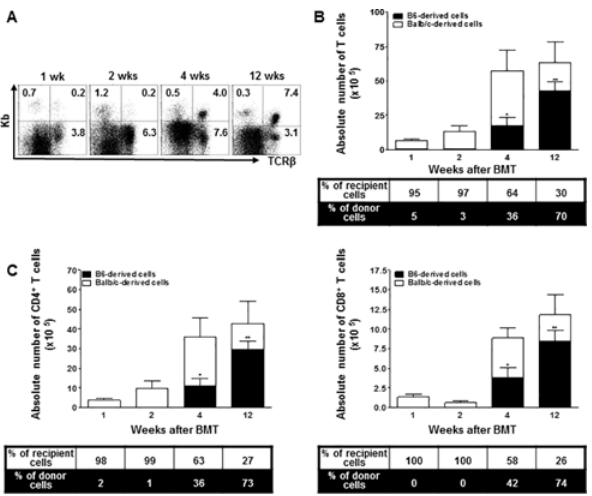
Fig 2. At weeks 1, 2, 4, and 12 after BMT, leukocytes isolated from the thymus were stained with anti- TCR β ,-CD4,-CD8,-K b , and-D d monoclonal antibodies ( n = 4 at each time point). (A) The numbers in the dot plot show the percentage of B6-originated T cells among the total leukocytes. (B) The bars show the ratio and absolute numbers of B6-orginated TCR β + T cells ( ■ ) and Balb/c-originated TCR β + T cells ( □ ). (C) The bars show the ratio and absolute numbers of B6(Balb/c)-originated TCR β + CD4 + and TCR β + CD8 + T cells. Data are shown as the mean ± SD. p values compared to donor-derived cells one week after BMT. ** , p (cid:1) 0.01, and * , p (cid:1)